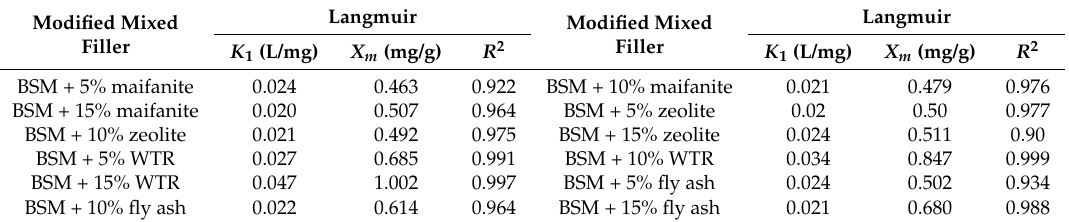
Table 6. Isothermal adsorption equation and parameters of modified mixed fillers for phosphorus. Modified Mixed Filler